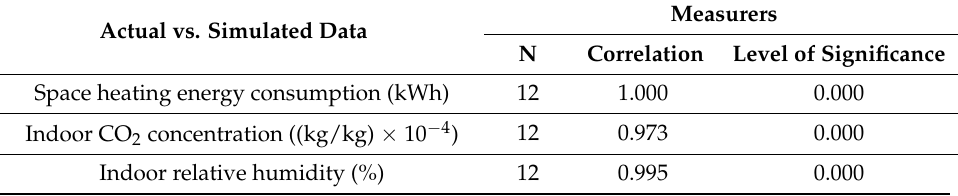
Table 5. Paired sample correlation t -test results between actual and simulated data for space heating energy consumption, indoor CO 2 concentration, and indoor relative humidity (RH) in 2020 for cases of leaky fans on in